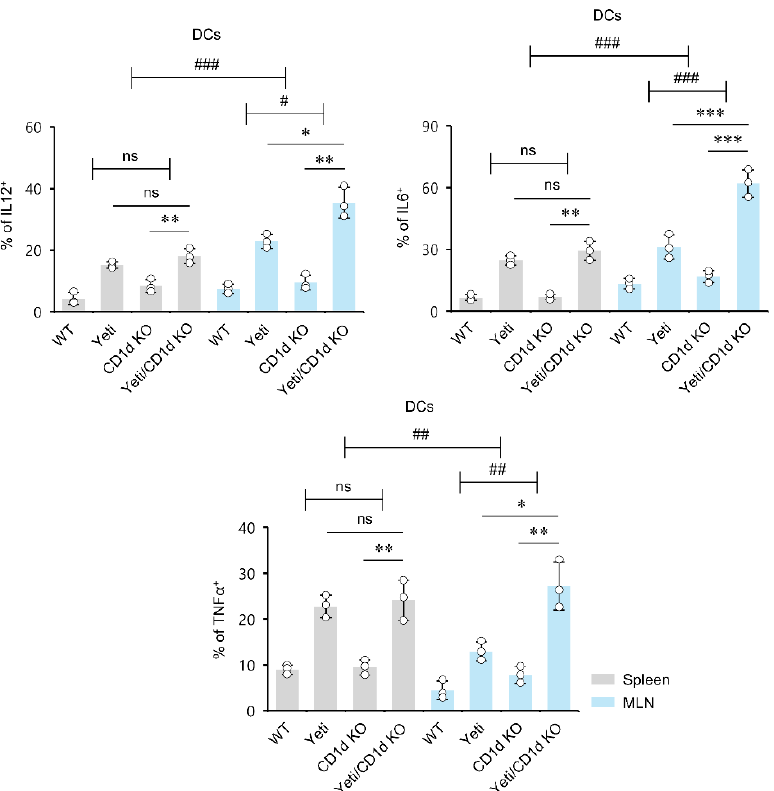
Figure 4. MLN Dysregulated IFNγ expression in the absence of iNKT cells causes DCs to produce proinflammatory cytokines in the MLNs during DSS-induced colitis. The spleen and MLNs were obtained from the indicated mice, as shown in Figure 1. Cytokine production (IL12, IL6, and TNF α ) by splenic and MLN CD11c + DCs was determined by flow cytometry on day 10. The mean values ± SD ( n = 3; per group in the experiment; Student’s t -test; * p < 0.05, ** p < 0.01, *** p < 0.001) are shown. Two-way ANOVA (Yeti × iNKT) showed an interaction between these two factors ( # p < 0.05, ## p < 0.01, ### p < 0.001). Two-way ANOVA (genotype × tissue) showed an interaction between these two factors ( ## p < 0.01, ### p < 0.001). One representative experiment from three experiments is shown. ns, not significant.